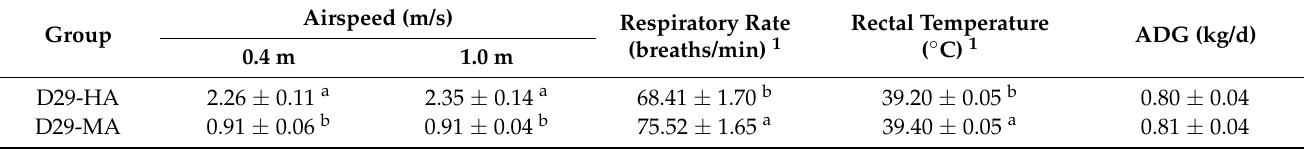
Table 6. Airspeeds, respiratory rates, rectal temperatures, and ADG (mean ± SEM) of calves of groups D29-HA and D29-MA. Airspeed Group